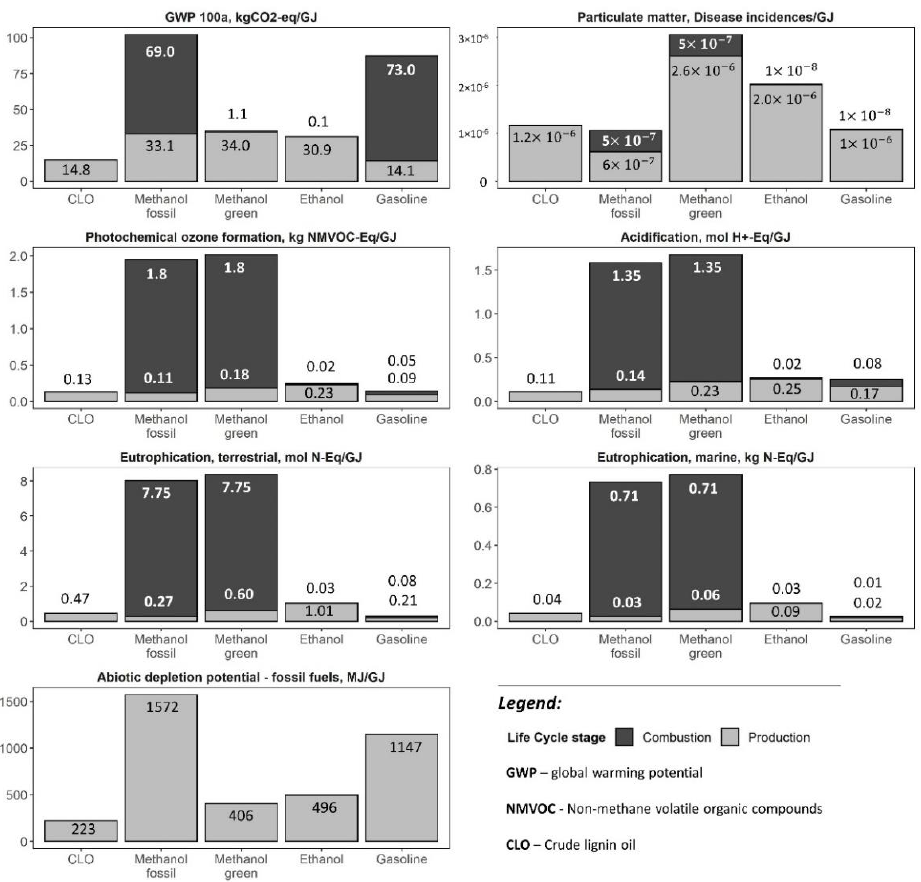
Figure 4. LCA results - base scenario (this figure excludes combustion emissions of CLO).